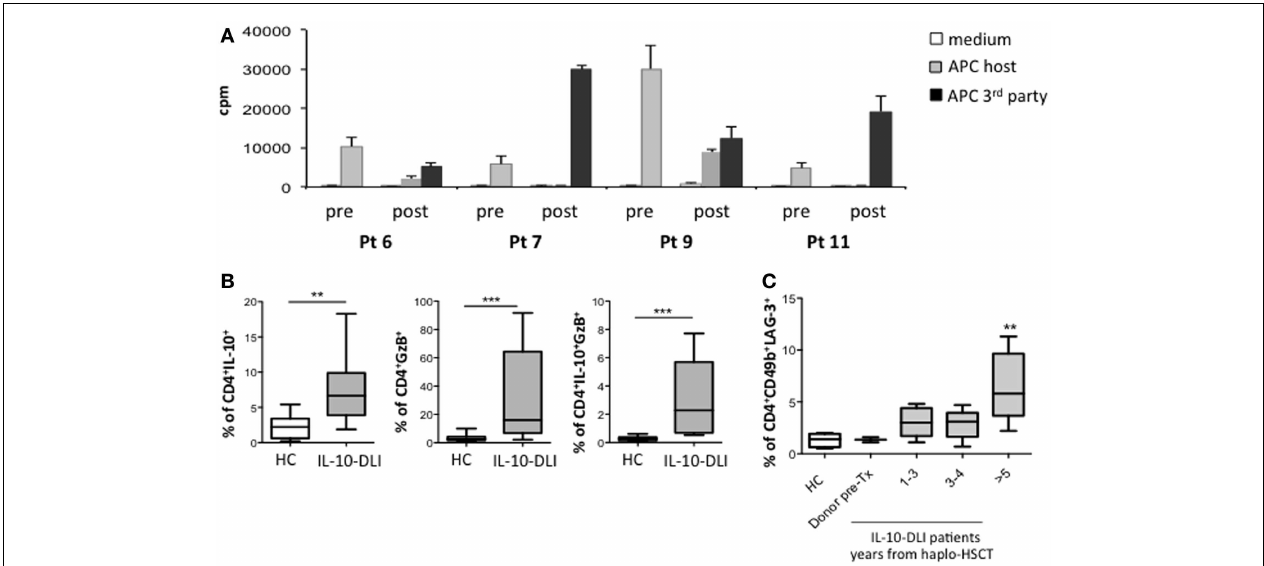
analyzed are shown, Differences were evaluated by means of the non-parametric Mann-Whitney U test. P -values < 0.05 were considered significant. (C) Surface CD49b and LAG-3 on gated CD4 + T cells from total PBMC of patients 6, 7, 9, and 11, tested 175days, 2.8, 3, and 5years; 180days, 1.5, 2.5, 4, 5, and 7years; 180days, 1.5, 2, 2.7, 4.2, 5, and 6years; 190days, 1year, 3.5, 4, 4.2, and 6years after IL-10-DLI, respectively, and of HC (HC: n = 5), and of donor PBMC of pt 7 and 9 (Donor pre-Tx). Mean ± SD of the percentages of CD49b + LAG-3 + T cells at indicated time-points are shown. Differences were evaluated by means of the non-parametric Mann-Whitney U test. P -values < 0.05 were considered significant. cpm: counts per minutes ofTritiatedThymidine